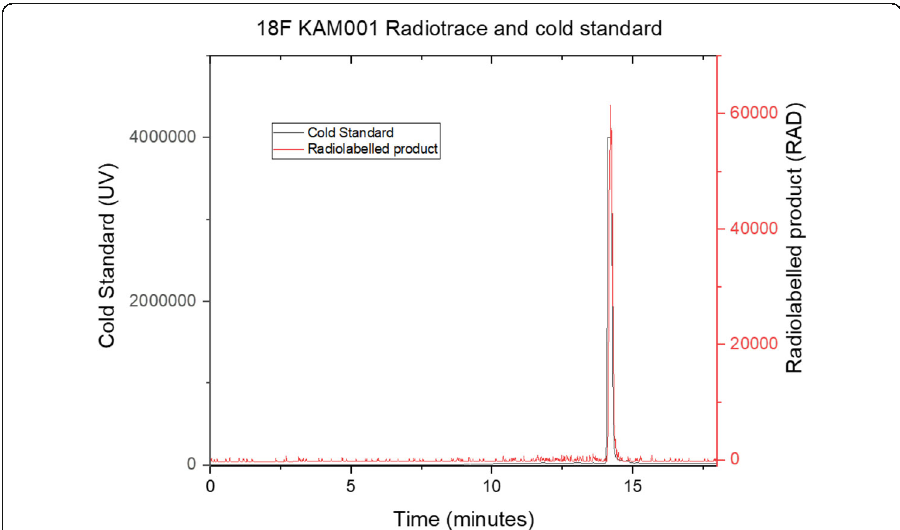
Fig. 4 18 F KAM001 identity confirmation using cold standard